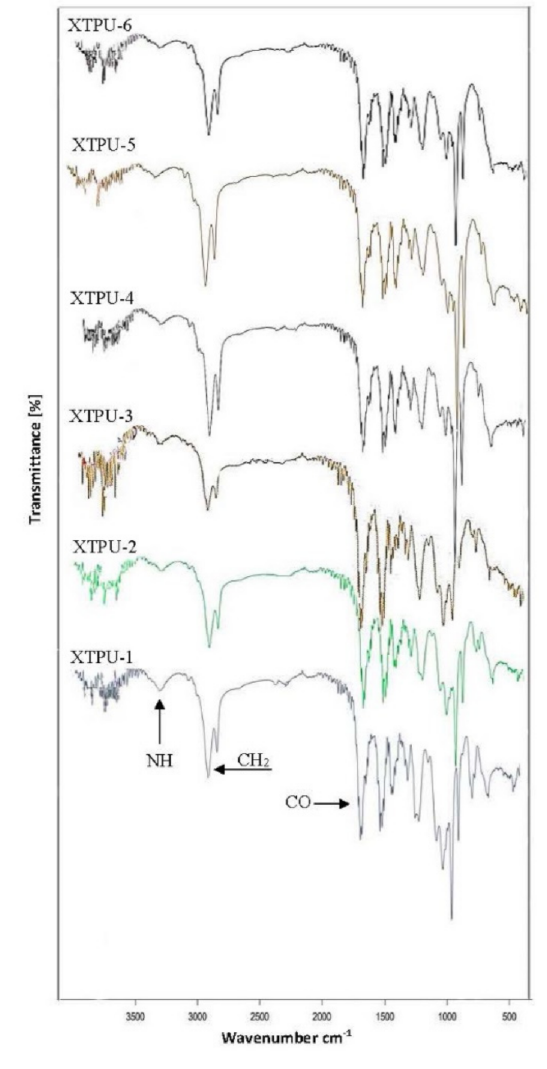
Figure 3. FT-IR spectrum of polyurethane samples XTPUs having 0–5% TiO 2 ,